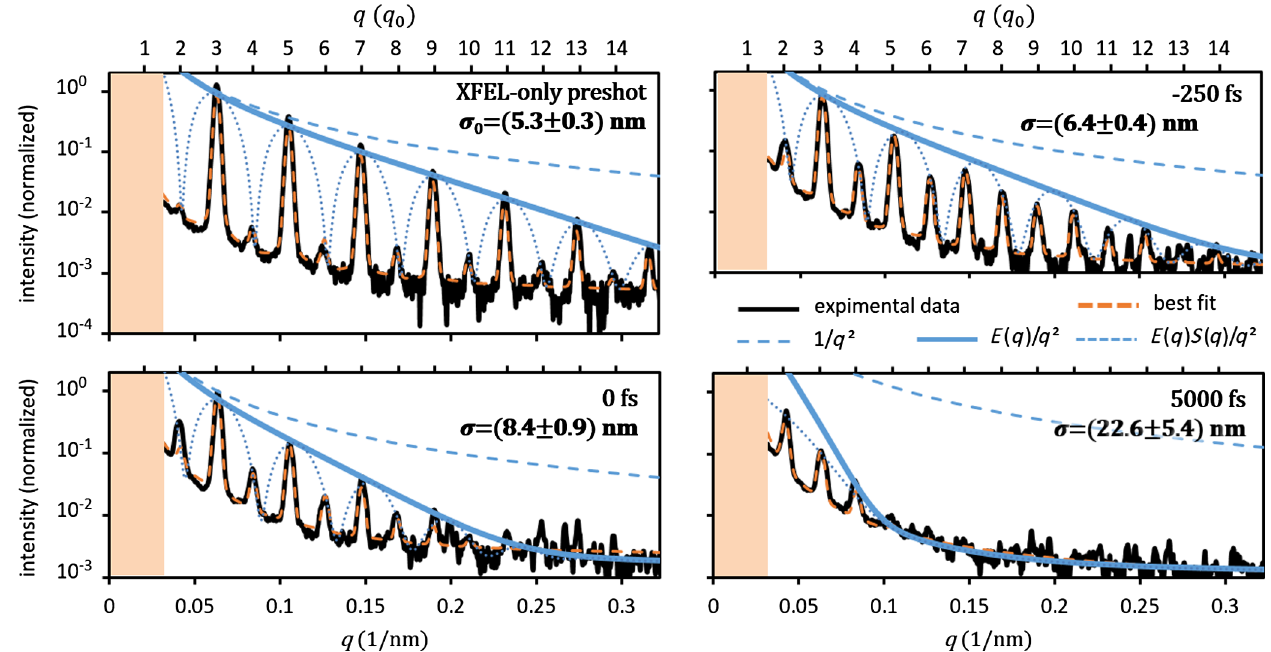
FIG. 2. Lineouts and fitting. Cuts through the horizontal direction through the scattering peaks of the SAXS pattern for the four shots shown in the right-hand side of Fig. 1 (black lines) and fitting results. From the full fits (dashed orange lines) the individual contributing terms of Eq. (1) are shown: 1 =q 2 corresponds to scattering from a perfectly sharp step (blue long dashed lines); E ð q Þ =q 2 from a smooth edge with expansion parameter σ (blue solid lines); and S ð q Þ E ð q Þ =q 2 from a single slit with smooth edges (blue dotted lines). Orange area marks the region with oversaturated pixels and was not used for ffiffiffi p 2 σ Þ þ 1 (cid:3) ,